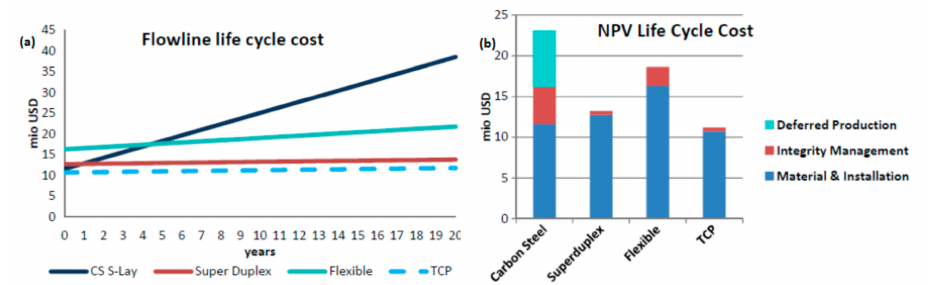
Figure 15. Potential of marine composites in TCP flowlines and composite risers, showing ( a ) flowline life cycle cost, and ( b ) NPV life cycle cost (Courtesy of 2H Offshore, Source: